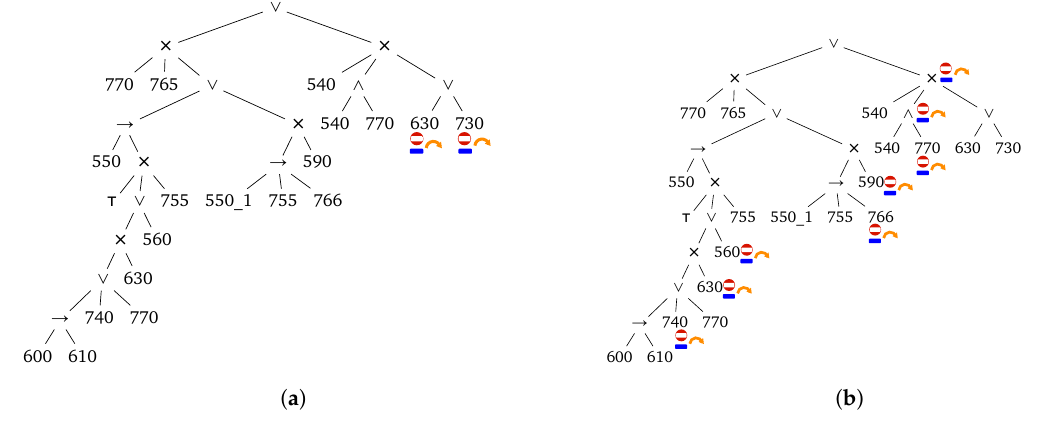
Figure 14. CPTs based on the model discovered by the ETM Approach 3. ( a ) CPT 3-A contains two configurable nodes; ( b ) CPT 3-B contains eight configurable nodes.